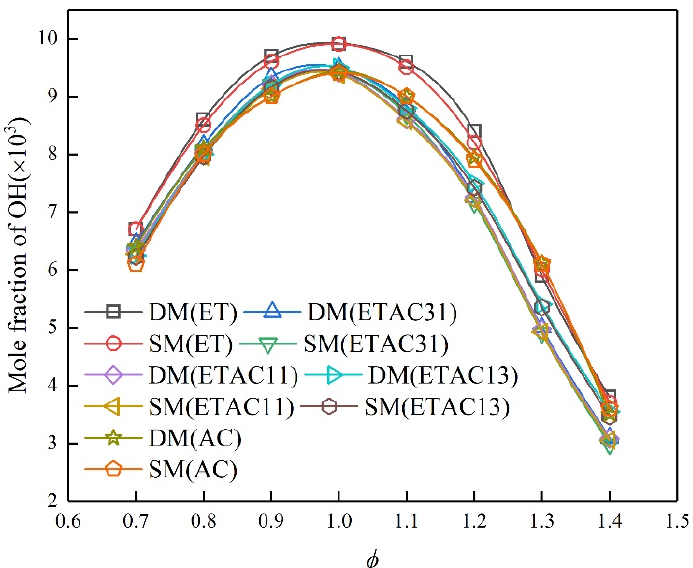
Figure 4. Comparison of OH mole fraction calculated by skeletal mechanism and detailed mechanism. DM: detailed mechanism; SM: skeletal mechanism.